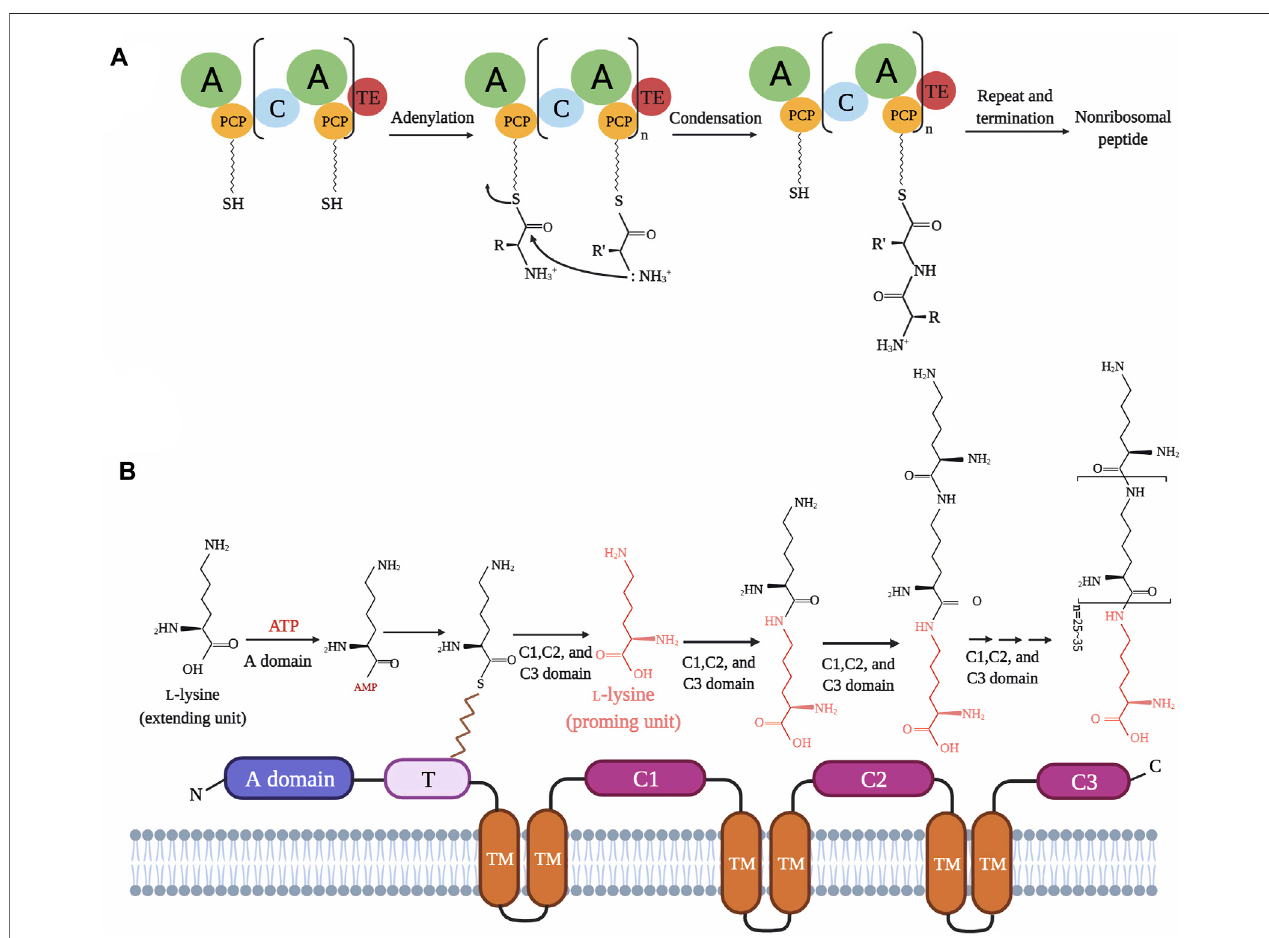
FIGURE 2 | Domain architectures and catalytic mechanisms of typical non-ribosomal peptide synthase (A) and ε -PL synthetase (in S.albulus , E. festucae and C. variabile ) (B) (Yamanaka et al., 2008; Xu et al., 2016; Purev et al., 2020; Jiang et al., 2021).